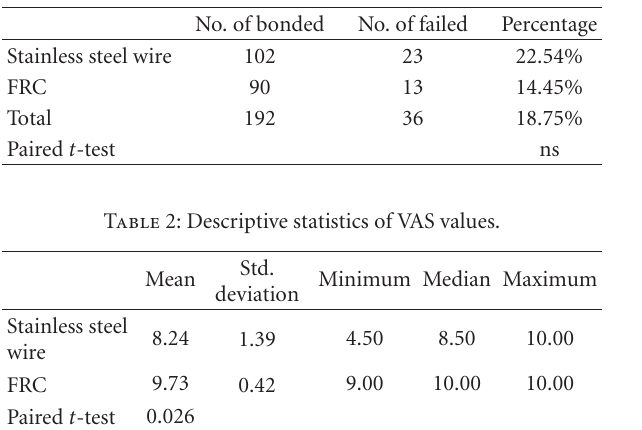
Table 1: Distribution of bond failures for the di ff erent retainer types. Numbers of single tooth detachment.